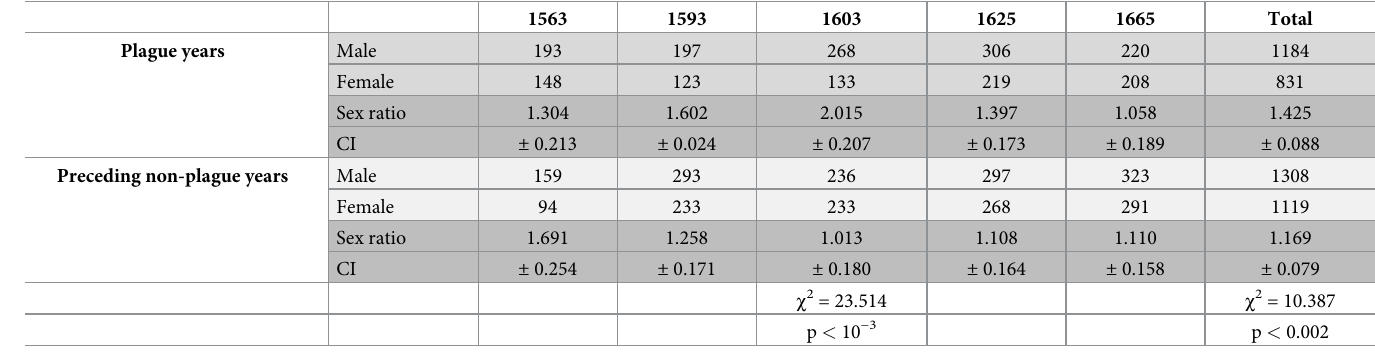
Table 4. A comparison between the frequency of male and female ‘adult’ burials for five plague years and the preceding non-plague years in selected parishes. The combined totals for plague and non-plague years are also